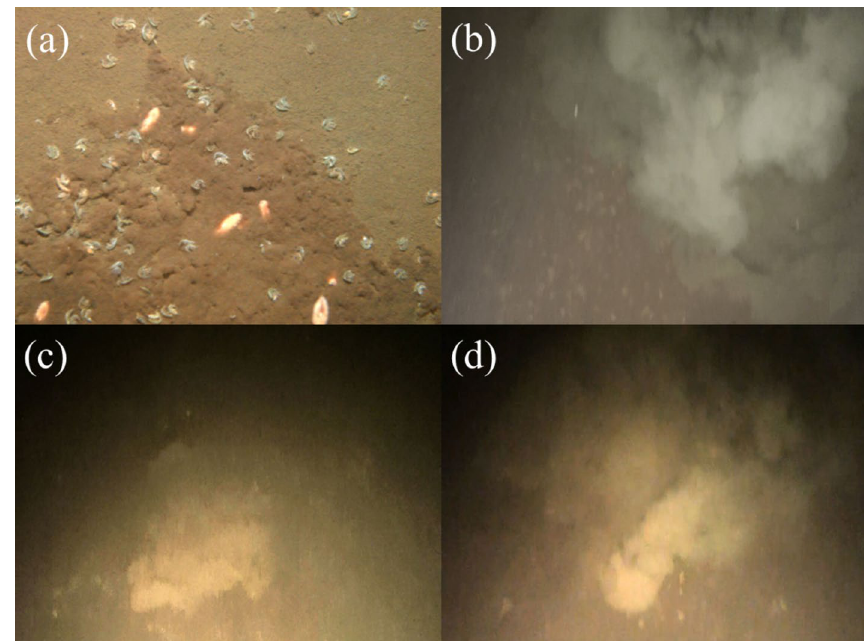
Figure 1. Photographs and images (from video film) taken by AUV “Tantan” in Lake Biwa at almost the same position as Fig. 2b. ( a ) Photo of benthic planarians ( Bdellocephala annandalei ), amphipods ( Jesogammarus annandalei ) and sediment disturbance near the deepest area on 25 August 2006. This digital camera image covers about 0.4 m in the horizontal and 0.3 m in the vertical planes. ( b ) A video image of a vent with high turbidity ebullition on 27 December 2009. The scale of this vent is nearly 2 m wide, 2 m deep and 1 m high. ( c ) Similar video image of a vent with a height of 0.5 m taken on 17 December 2010. ( d ) Video image of a vent detected with a height of 0.5 m and growing with a 1 m vertical scale and 4 m horizontal scale taken on 7 January 2012. The locations where images ( a – d ) were obtained are indicated in Fig. 3.